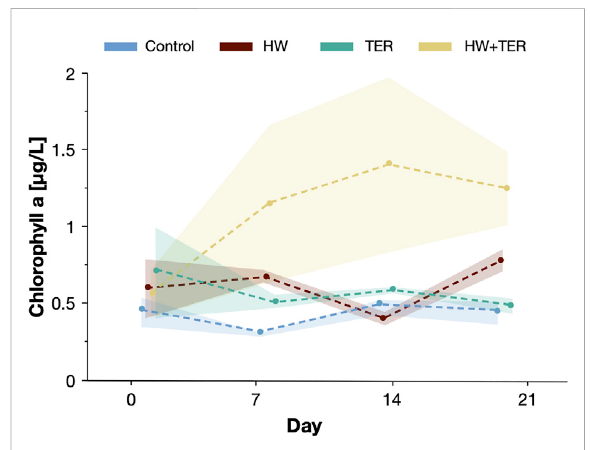
FIGURE 2 Chlorophyll-a concentrations [µg/L] measured over time in all treatments: control (blue), heatwave (HW, red), terbuthylazine (TER, green), and the combination of a heatwave and terbuthylazine (HW + TER, yellow). The shaded areas indicate the standard error from the mean. The points indicate the data points and the dashed lines connect the means of these data points. The data points were slightly shifted to avoid overlapping and allow optimal visualisation.